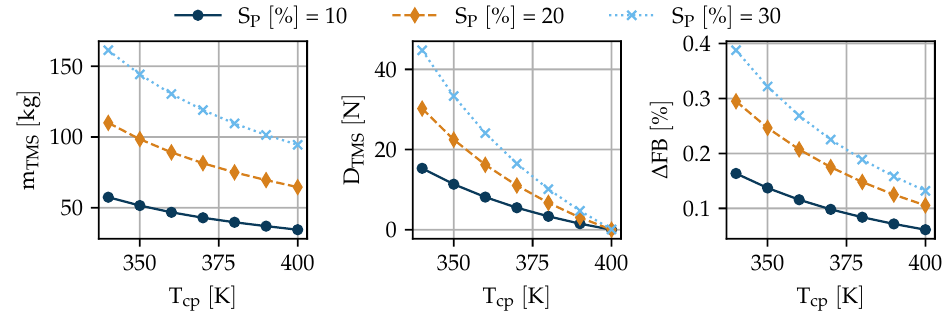
Figure 10. Design optimization results for different S P